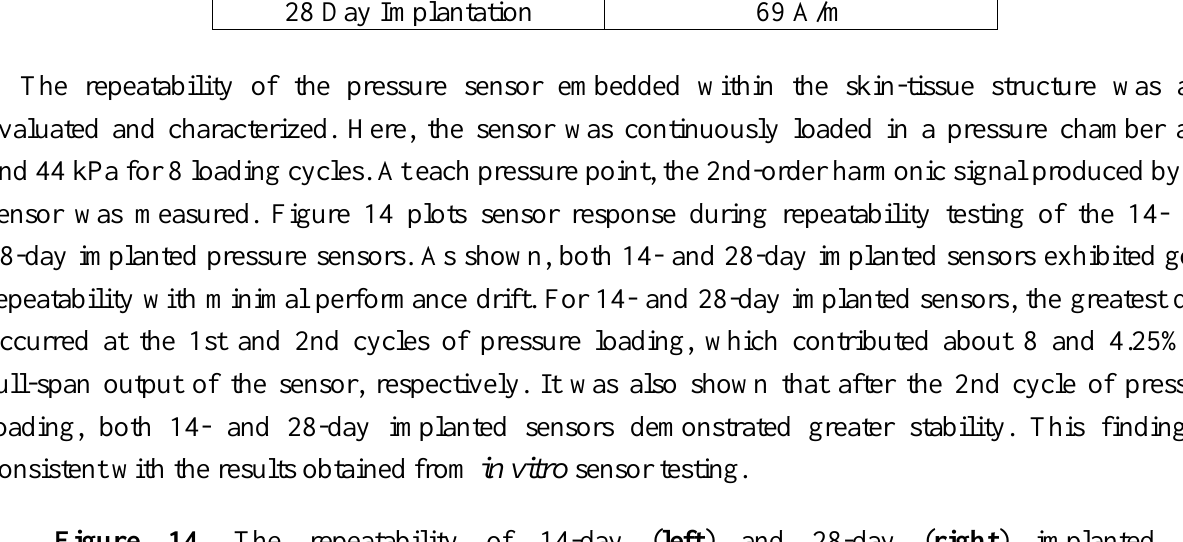
Figure 14. The repeatability of 14-day ( left ) and 28-day ( right ) implanted magneto-harmonic pressure